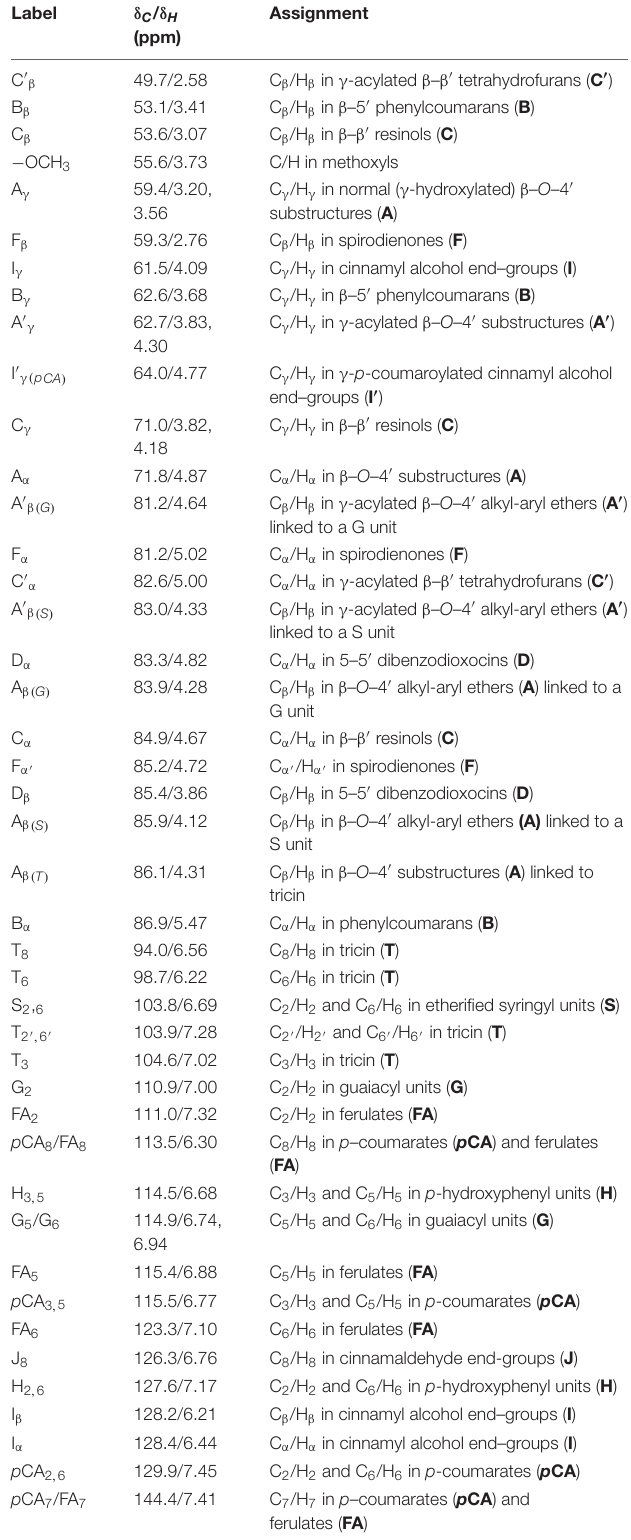
TABLE 3 | Assignments of the lignin 1 H/ 13 C correlation signals in the 2D HSQC spectra from the whole cell walls of rice husks and straw and their isolated MWLs (in DMSO– d 6